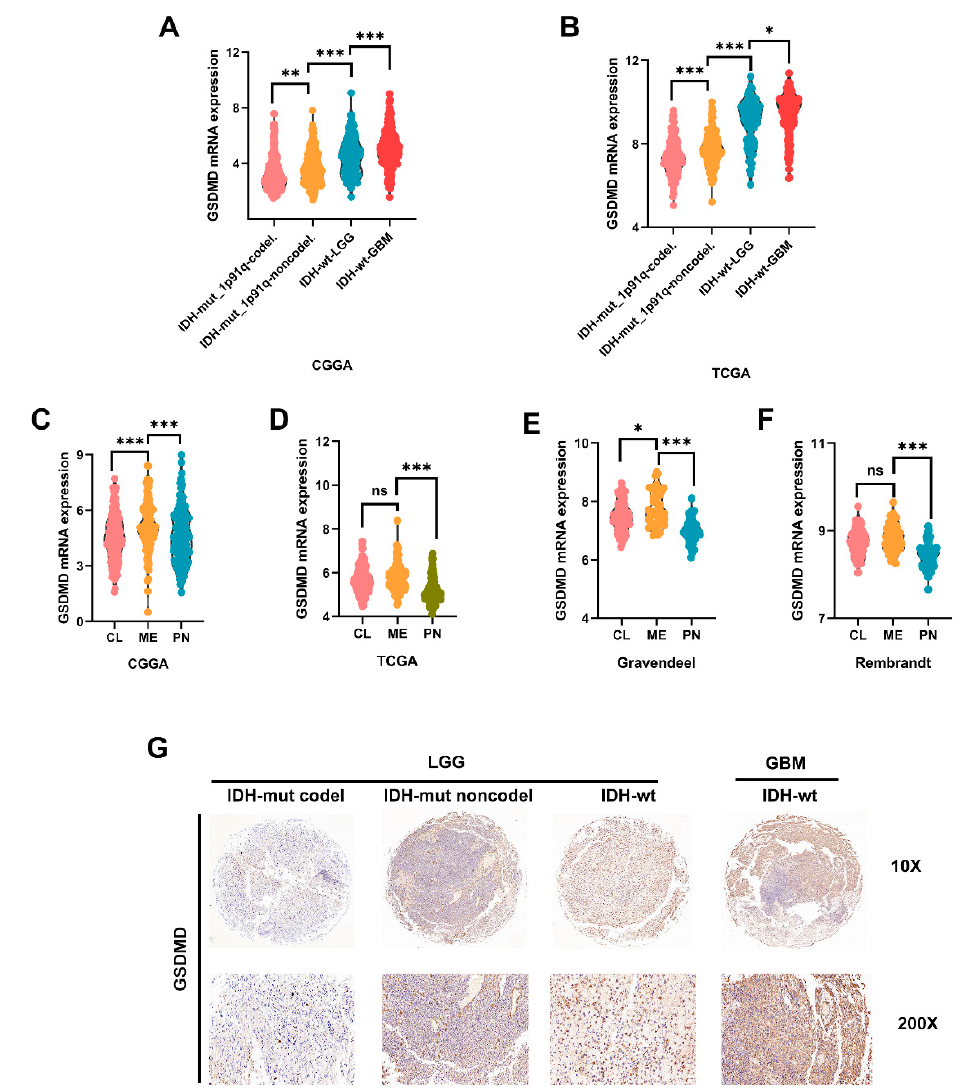
Figure 6. High GSDMD expression associated with IDH wildtype, 1p19q co-deletion and subtypes ( A , B ) GSDMD expression in glioma tissues with different molecular characteristics. IDH and 1p19q status of glioma in CGGA and TCGA datasets were all downloaded from GlioVis. IDH, isocitrate dehydrogenase. WT, wildtype. Mut, mutant. ( C – F ) GSDMD expression in different subtypes of GBM was analyzed in CGGA, TCGA, Gravendeel and Rembrandt datasets. CL, Classical; ME, mesenchymal; PN, proneural. ( G ) IHC staining was used to detect GSDMD expression in glioma tissues (in-house cohort) with different IDH and 1p19q status. * p < 0.05. ** p < 0.01. *** p < 0.001. ns, no